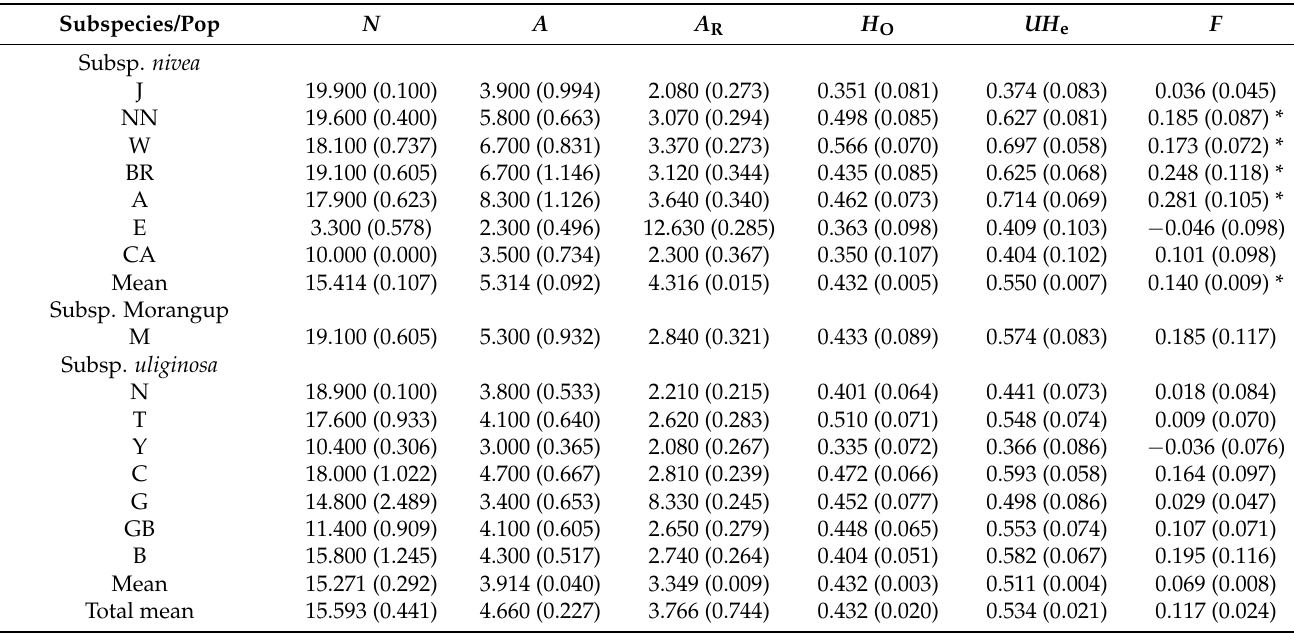
Table 1. Diversity statistics based on 10 nuclear microsatellite loci for populations of Banksia nivea from south-western